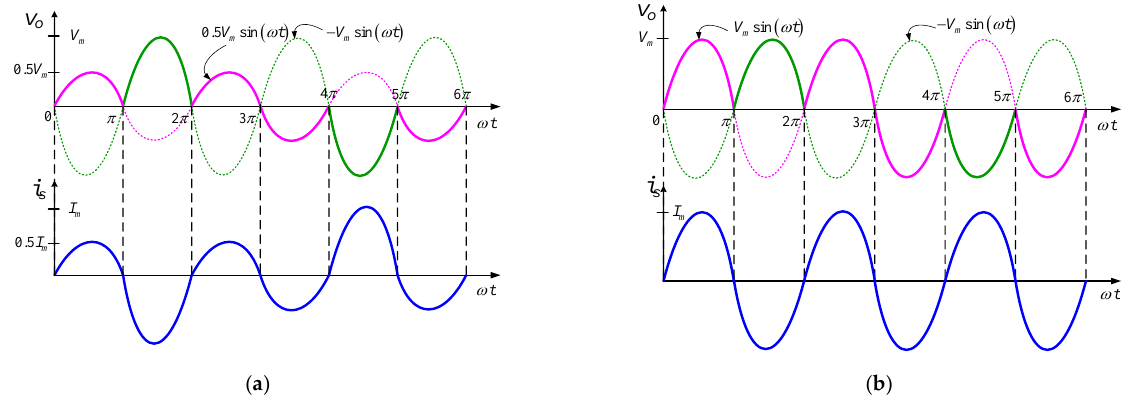
Figure 5. Output voltage for one-third frequency operation with respect to input for voltage ( a ) regulated form and ( b ) non-regulated form.